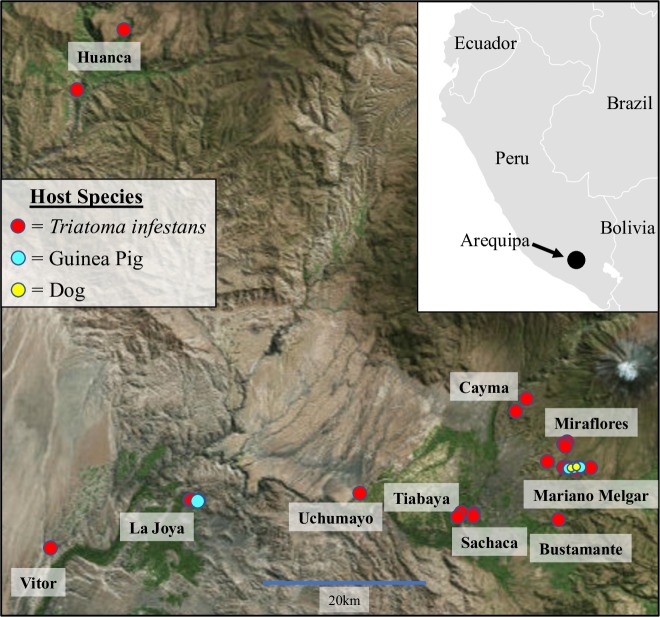
Geographic distribution of isolates.The location of all 123 sampled T. cruzi are represented by dots and colored by the host species. Inset shows the location of Arequipa. Map of Arequipa was obtained from https://landlook.usgs.gov and was modified using QGIS v. 2.18 [69]. Inset was modified from https://commons.wikimedia.org/wiki/Atlas_of_the_world.